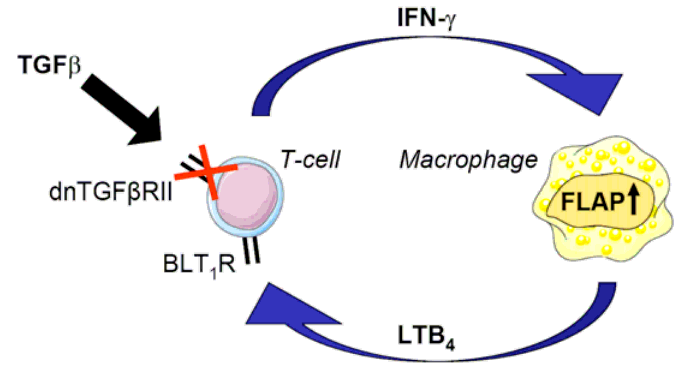
FIGURE 1. Schematic drawing of the macrophage/T-cell cross-talk inducing increased LTB 4 synthesis through up-regulation of FLAP expression[10]. The dampening effect of TGF β on T cells was disrupted by a dominant-negative (dn) TGF β RII under the control of the CD4 promoter, resulting in increased T-cell activation and interferon (IFN)- γ production. The elevated LTB 4 concentrations secreted from the vascular wall induce chemotaxis and recruitment of further T cells through activation of the T-cell BLT 1